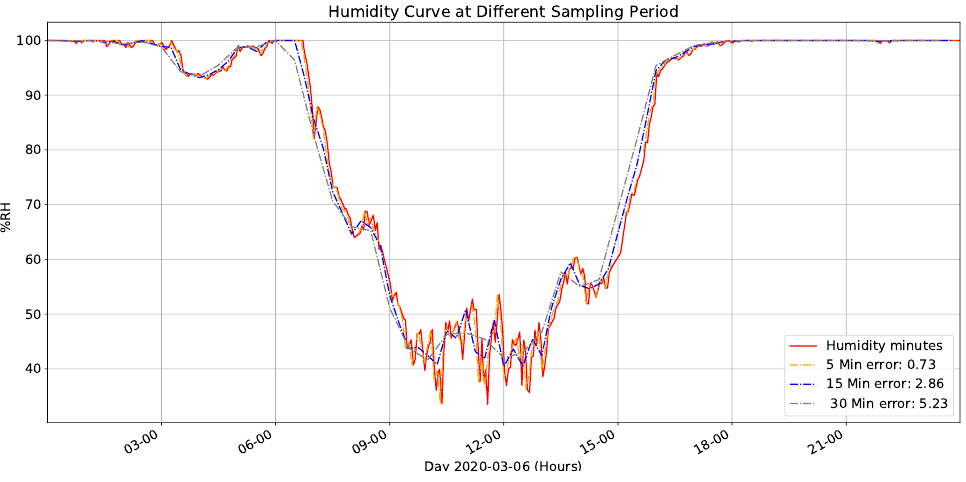
Figure 13. Humidity for different sampling